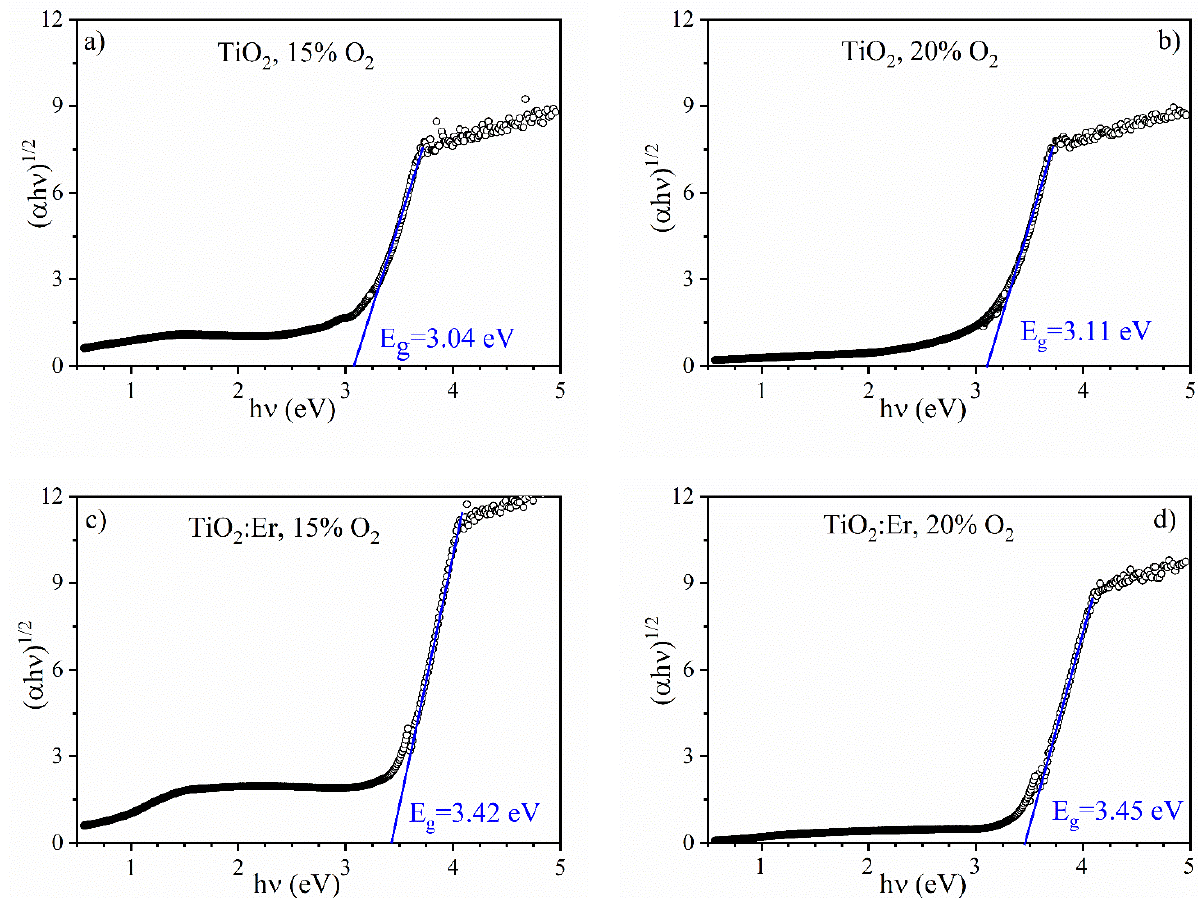
Figure 9. Band gap E g determination for thin films—spectral dependence of the ( α h ν ) 1/2 coefficient vs. photon energy h ν : undoped TiO 2 ( a ) 15% O 2 and ( b ) 20% O 2 ; TiO 2 :Er ( c ) 15% O 2 and ( d ) 20% O 2 .